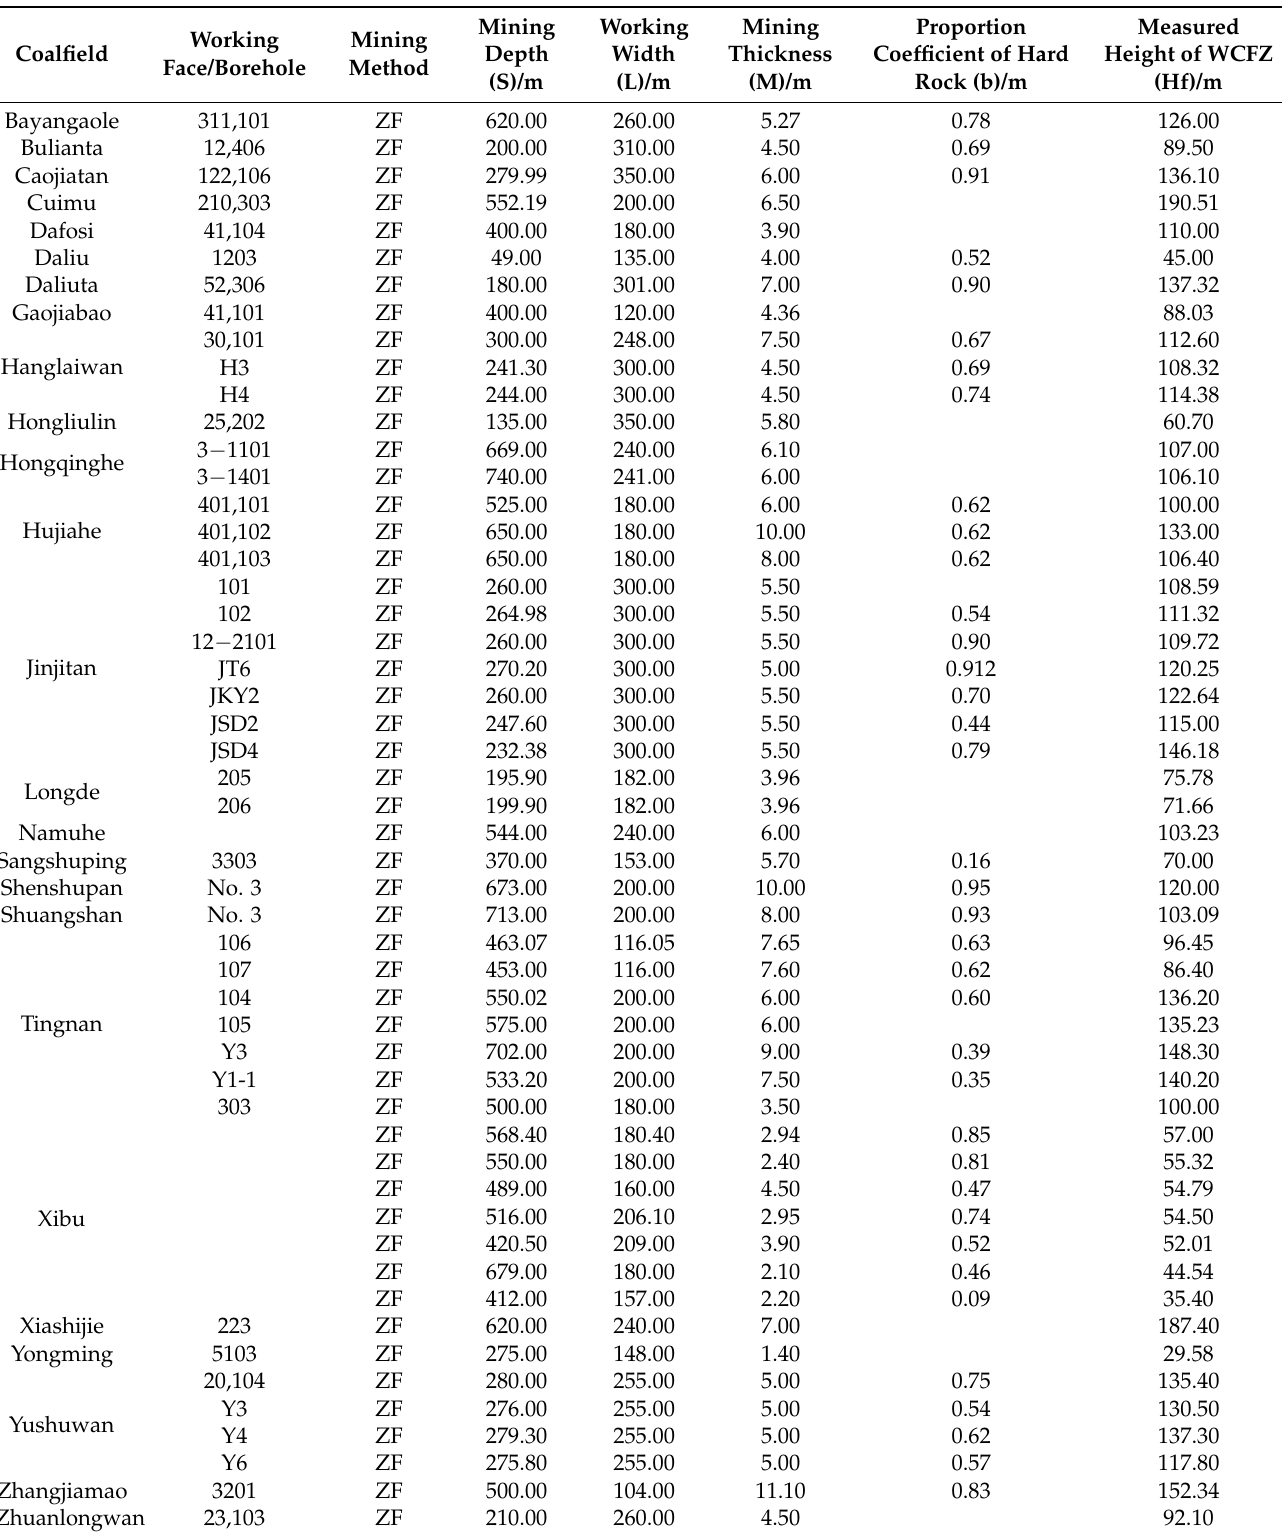
Table 1. Measured height of